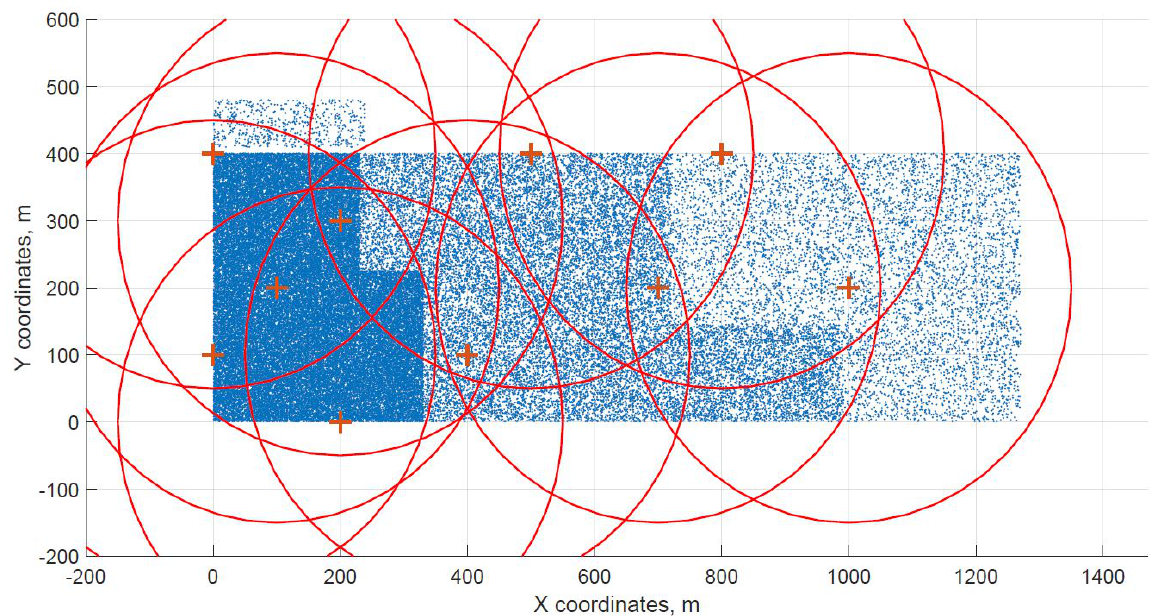
Figure 5. Differential evolution resulting grid for dataset